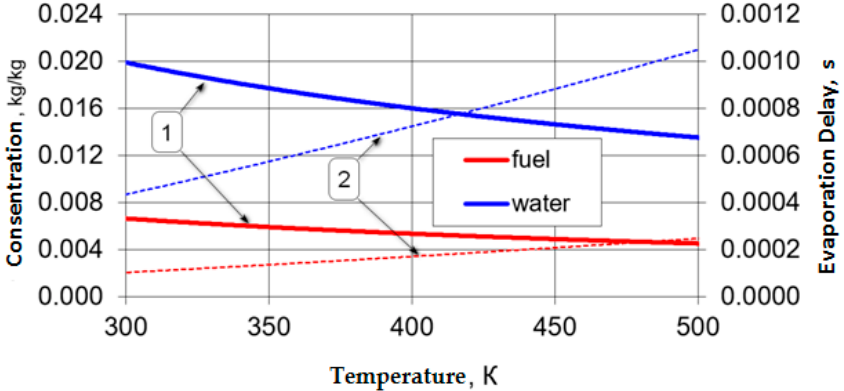
Figure 9. Dependence of the concentration (1) and the period of the evaporation delay (2) of fuel and water on the temperature of gases at the inlet to the intake manifold. (Source: Authors).